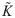
Quantifying chromatin condensation in Arabidopsis plant cells using the same dataset published by Poulet et al [52].
Panel A: Sample images from the two constructs tested: wt (wild type) and crwn1 crwn2 mutant. Crwn1 crwn2 mutant is known to have less chromocentres than wt. Panel B: K˜ values for the two constructs tested. The number of nuclei analyzed in the wt and crwn1 crwn2 constructs is 38 and 39 nuclei, respectively. Error bars represent the standard error of the mean (SEM).